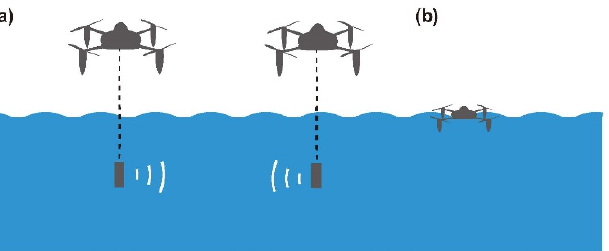
Figure 1. Conceptual schematics for underwater communication using UAVs and AUVs. ( a ) Hang- ing an acoustic base station from a UAV hovering above the sea surface during an AUV survey. ( b ) Acoustic base station installed on a sea-surface UAV during an AUV survey. ( c ) Hanging both an underwater sonar and acoustic base station from a hovering UAV. ( d ) Suspending an underwater sonar from a hovering UAV with an acoustic base station installed on a sea-surface UAV. ( e ) Trans- porting a UAV with an AUV. ( f ) Retrieving an AUV with a UAV.